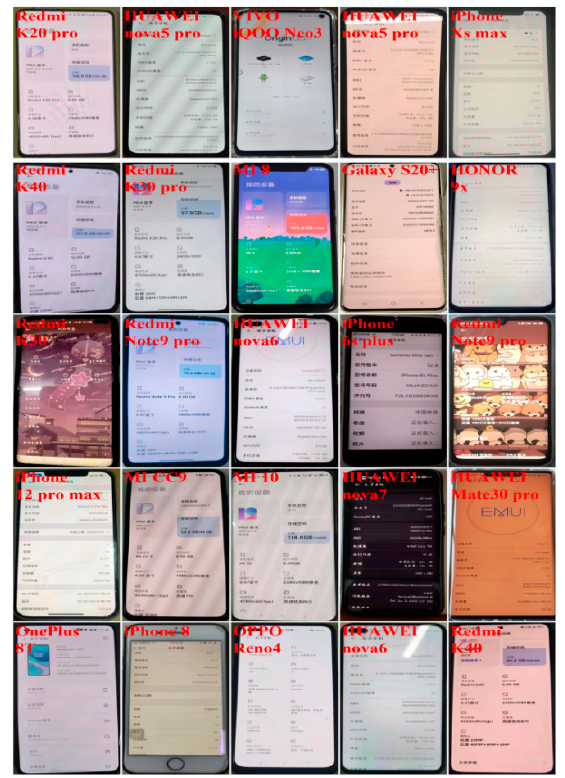
Figure 11. Brands and models of 25 smartphones.